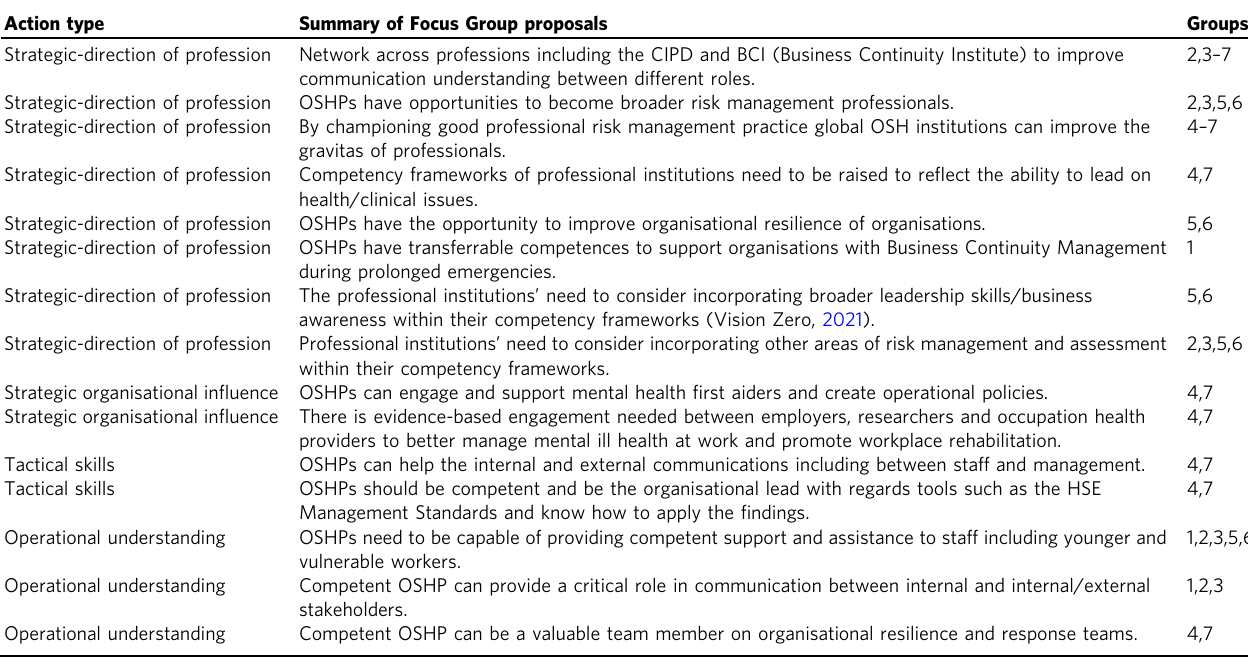
Table 5 Summary of results — professional direction.